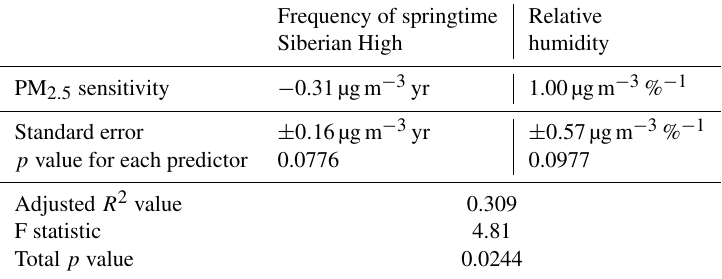
Figure 7. Detrended annual mean total PM 2 . 5 concentration and climate variables chosen by the forward selection model of 1998–2015, including (a) annual mean frequency of springtime Siberian High ( r = − 0 . 51) and (b) relative humidity ( r = 0 . 49). Annual mean surface PM 2 . 5 concentrations are derived from satellite AOD by van Donkelaar et al. (2016). All variables are detrended by subtracting the 7-year moving averages from the annual mean values. Table 2. Regression model that explains interannual variability of satellite-derived PM 2 . 5 in Beijing–Tianjin–Hebei